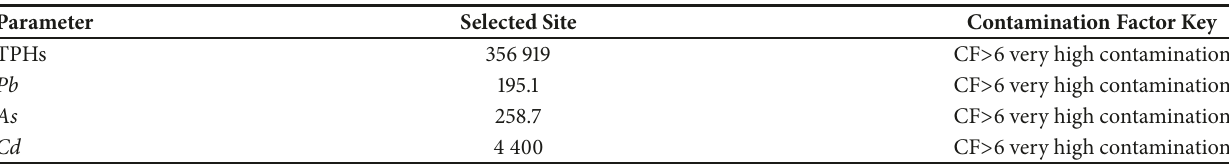
Table 2: Contamination